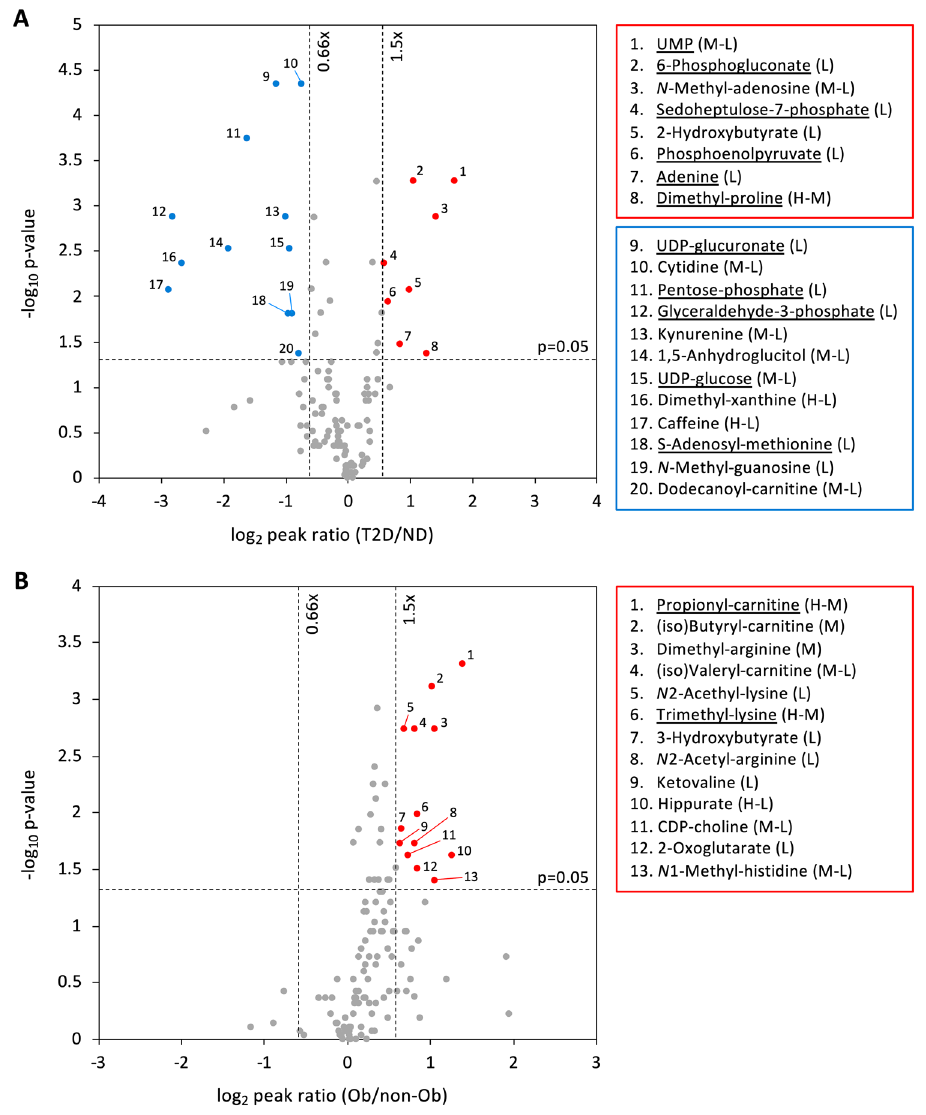
Figure 2. Volcano plot analysis of blood metabolites. The identified 125 compounds are plotted. The x-axis is the log2-fold change, whereas the y-axis is the -log10 p value of the Mann–Whitney U-test. Two vertical dashed lines indicate 0.66 and 1.5-fold changes. The horizontal dashed line shows a p value = 0.05. ( A ) Metabolites that were more than 1.5 times higher in T2D than ND are shown in red, and metabolites that were less than two- thirds (0.66 times) lower are shown in blue. ( B ) Similar to ( A ), metabolites that were more than 1.5 times higher in Ob than non-Ob are shown in red, and metabolites that were less than two-thirds (0.66 times) lower are shown in blue. The highlighted 20 compounds in ( A ) and 13 in ( B ) were identified as T2D markers and obesity markers, respectively. RBC-enriched compounds are